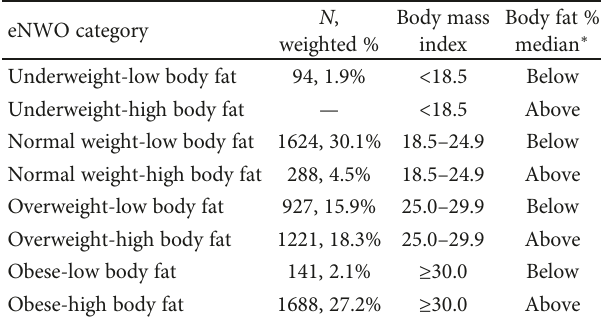
Table 1: Expanded normal weight obesity (eNWO) categories, de fi ned by BMI and body fat percentage status.